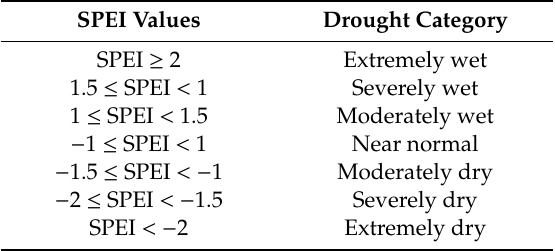
Table 2. Drought characterization based on standardized precipitation evapotransporation index (SPEI) values.